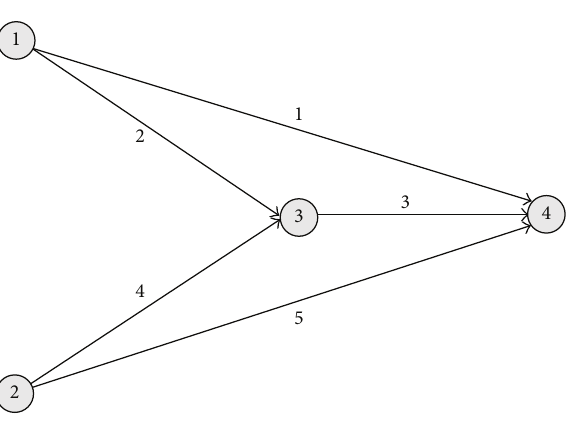
Figure 1: The network used in the